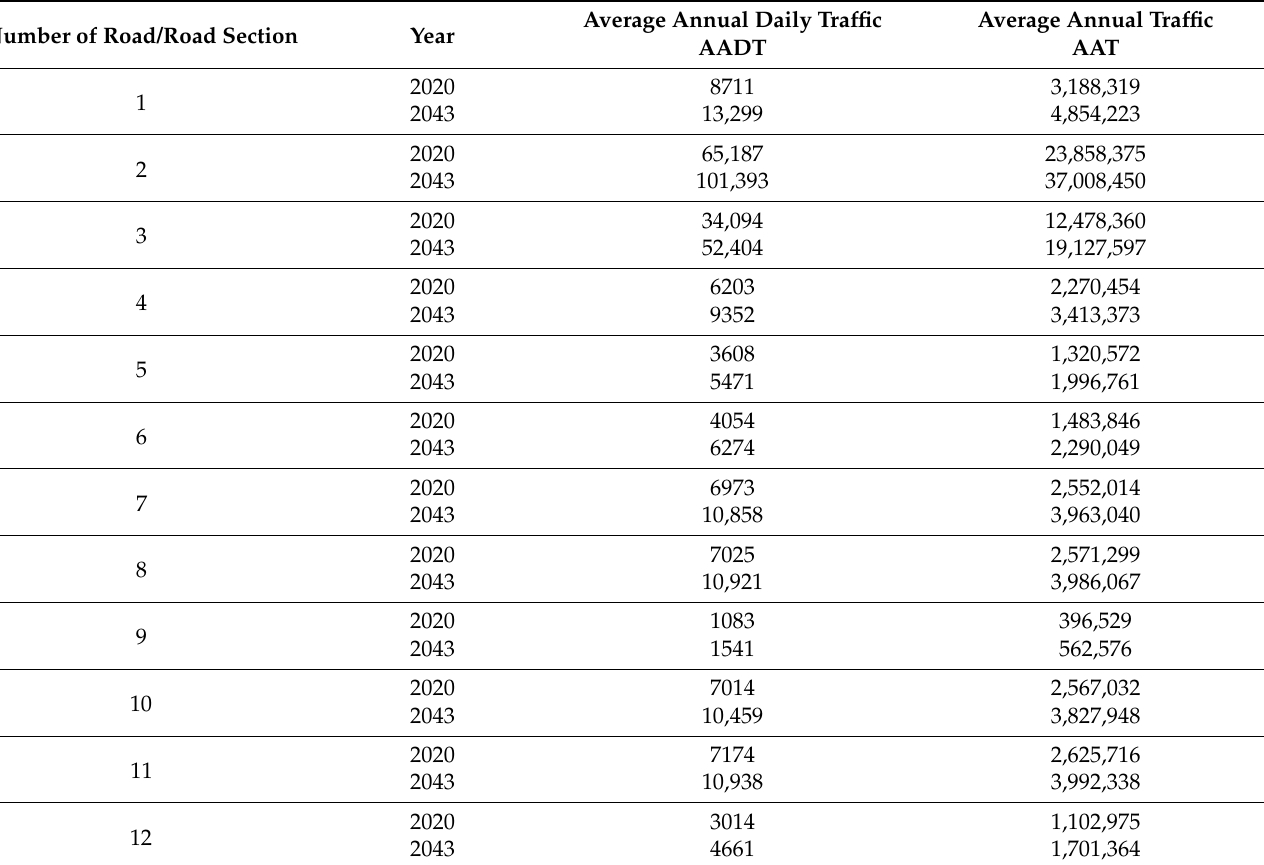
Table 3. Forecasted truck traffic on roads in urban-port road transport system in the selected years of the forecasting period (no. of trucks). Number of Road/Road